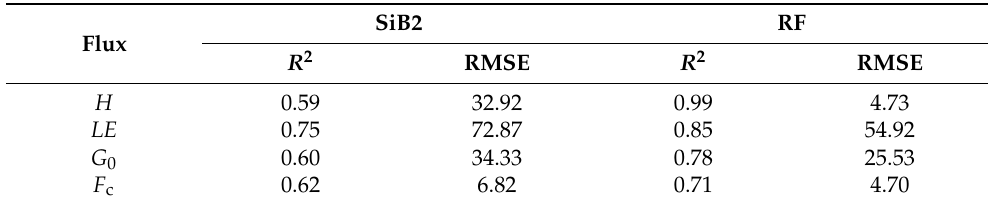
Figure 8. Comparison of the ( a ) R 2 and ( b ) RMSE values for the fluxes of sensible heat ( H ), latent heat ( LE ), soil heat ( G 0 ), and CO 2 ( F c ) during the different growth stages of wheat in the SiB2 and RF-corrected model outputs. The degree of improvement is indicated by the percentages over each bar. Table 1. The values of R 2 and RMSE for the overall growth period in the SiB2 and RF-corrected model